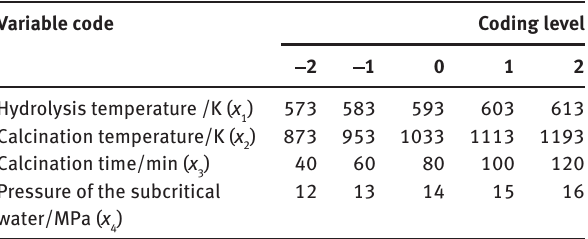
Table 1: Four-factor design table. Variable code Coding